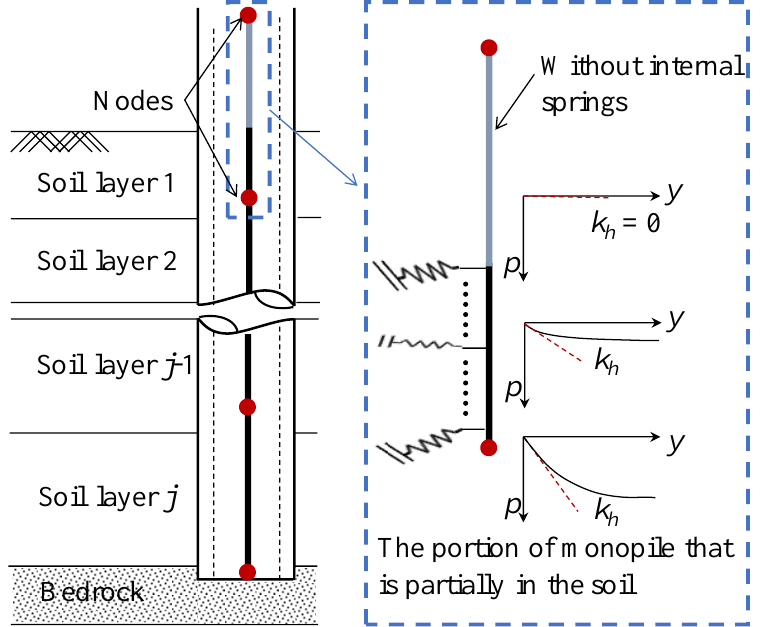
Figure 4. Relationship of soil resistance versus displacement for the monopile embedding in multi- layer soil.